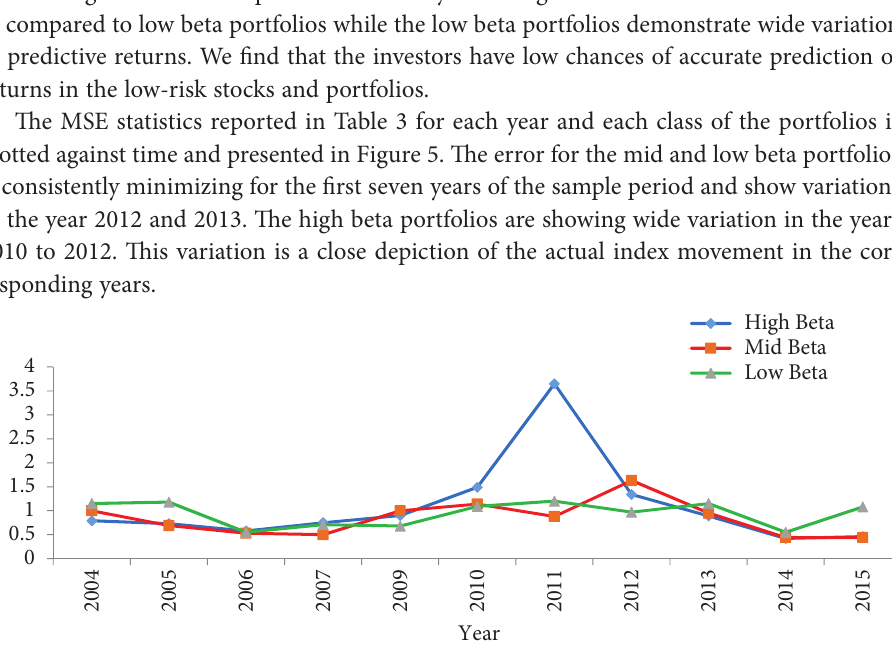
Figure 5. MSE score of high, mid and low portfolios under rolling windows